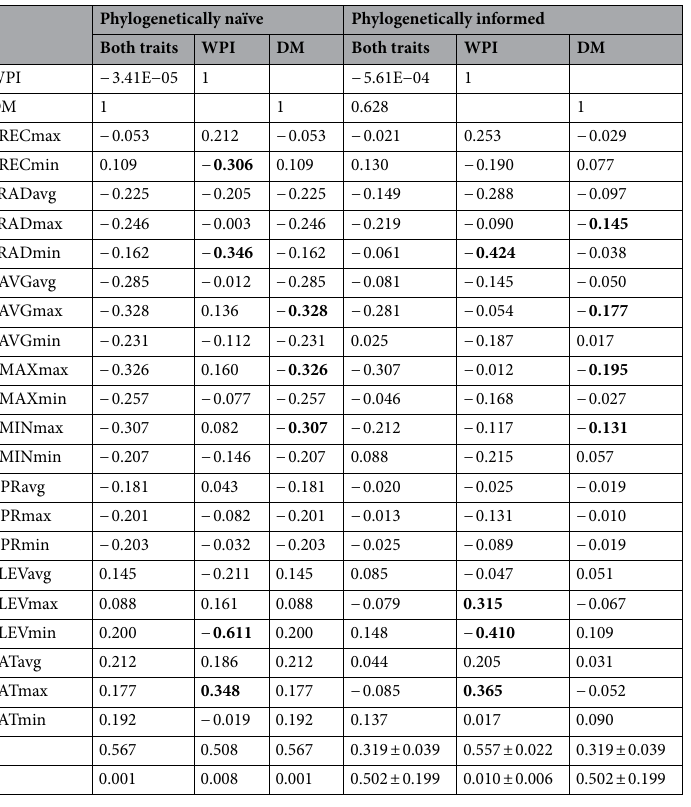
Table 2. Vector loadings of PLS analyses between pigmentation traits and range descriptors. Variables with a relatively high contribution are highlighted in boldface. r Pearson coefficient between PLS vectors, p corresponding p-value over 1000 iterations. For phylogenetically informed analyses means and standard errors of r and p over 1000 phylogenies are